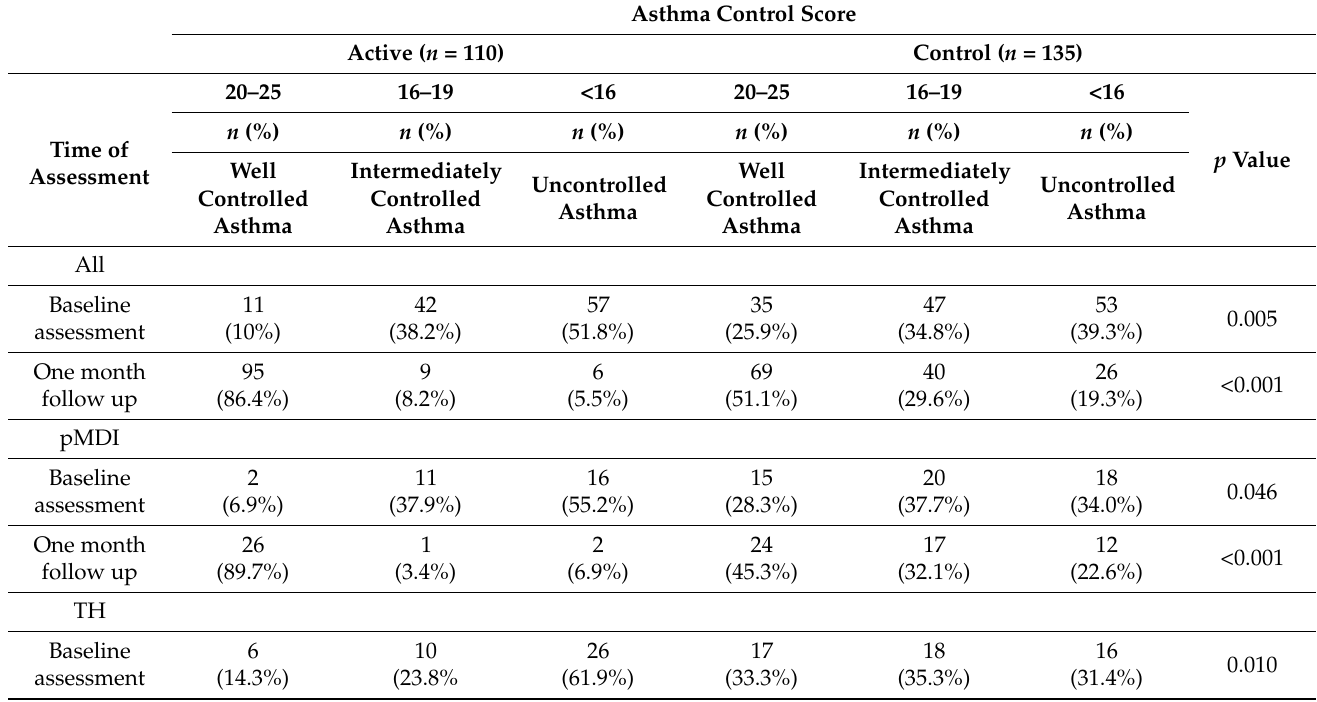
Table 5. Assessment of asthma control test (ACT) for both active and control